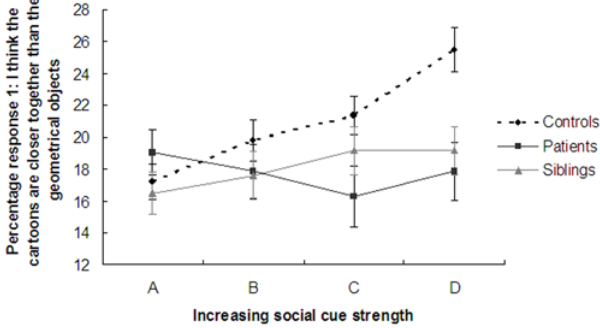
Figure 2. Linear increase in response 1 (‘‘Cartoons Closer’’) consistent with social cue strength in healthy control subjects, but not in patients or sibling of patients.